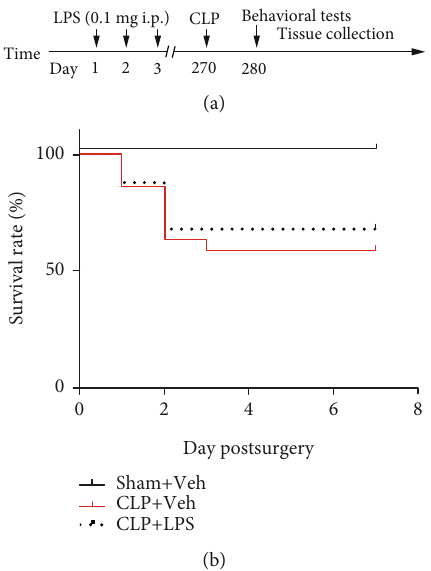
Figure 1: Timeline of the experimental procedure in mice (a). E ff ects of CLP and repeated LPS injections on survival rate (b). LPS: lipopolysaccharide; CLP: cecal ligation and puncture; Veh: